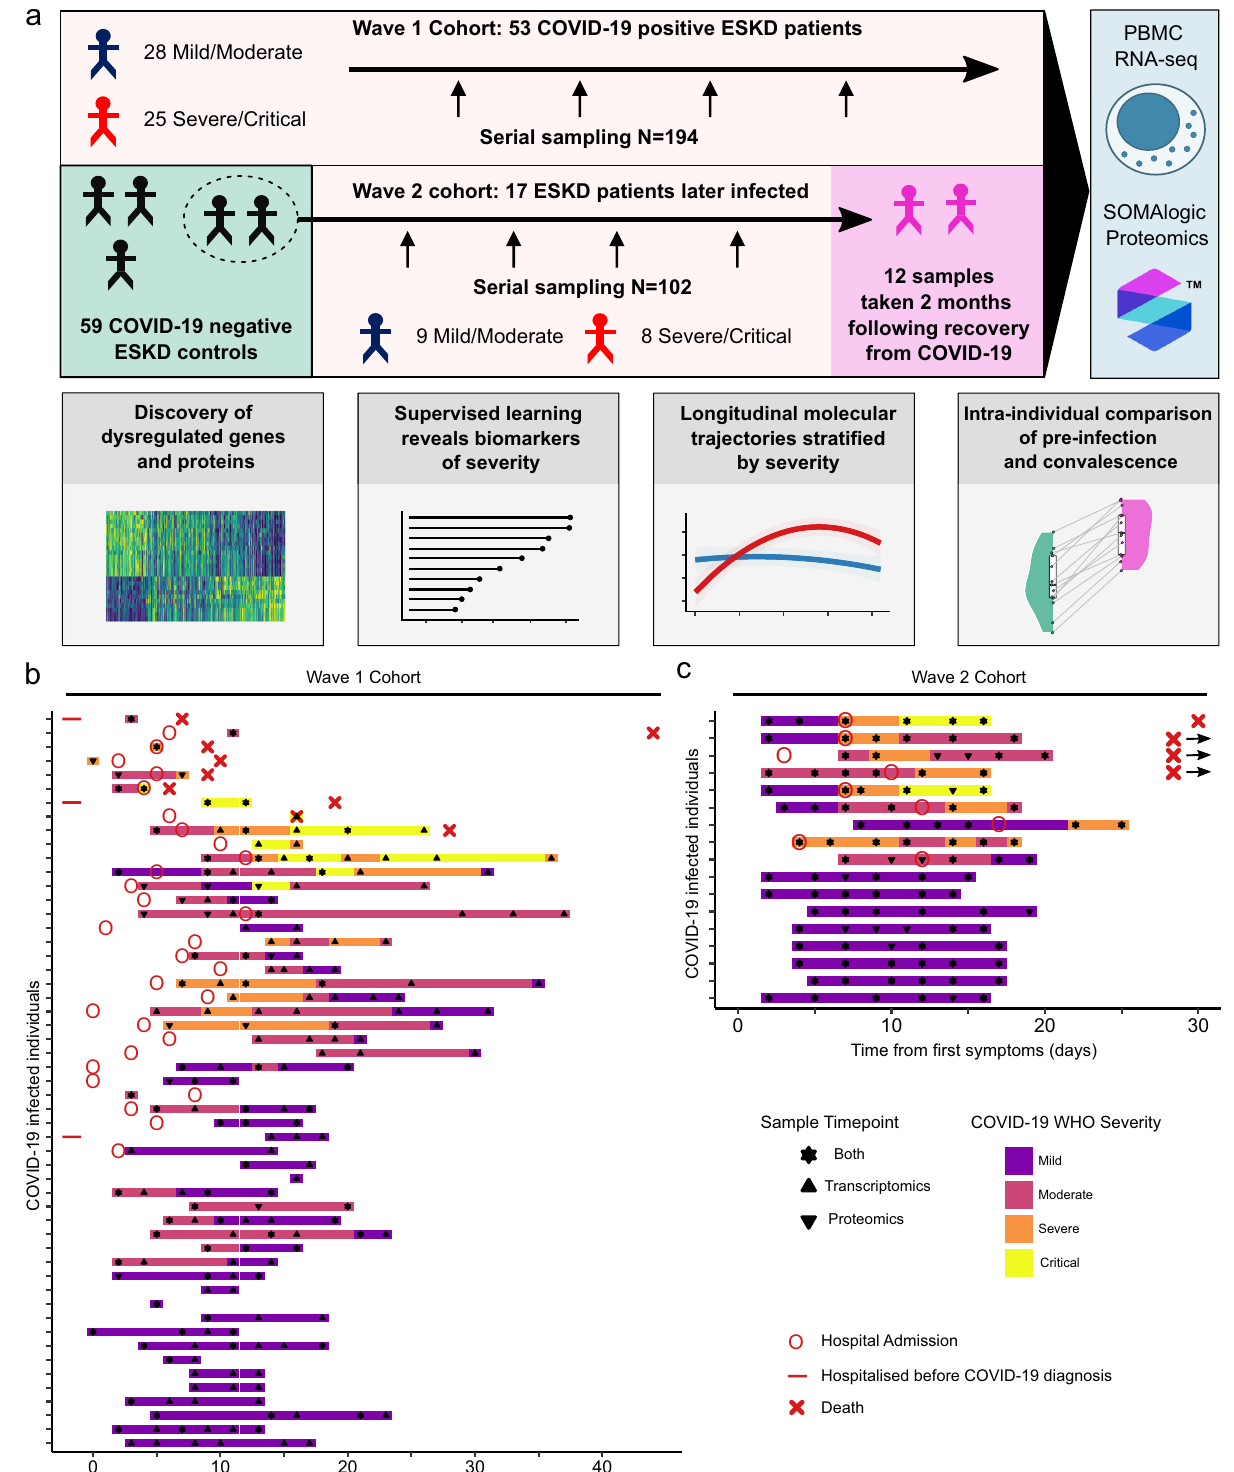
Fig. 1 | Study design and cohort summary. a Graphical summary of the patient cohorts, sampling, and major analyses. Wave 1 patients were recruited in Spring 2020. 17 of the COVID-19 negative ESKD patients recruited as a controls in Wave 1 were recruited again as COVID-19 positive cases in Wave 2 (2021). For 12/13 survi- vors in Wave 2, we obtained a convalescent sample approximately 2 months fol- lowingrecovery.Thus,forWave2,wehadpairedpre-infection,acuteinfectionand